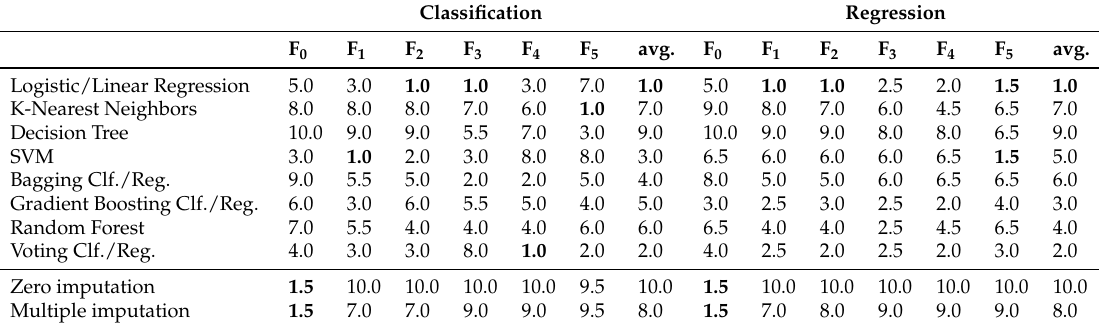
Table 12. Rankings of classification and regression models for different feature sets for the target salt.